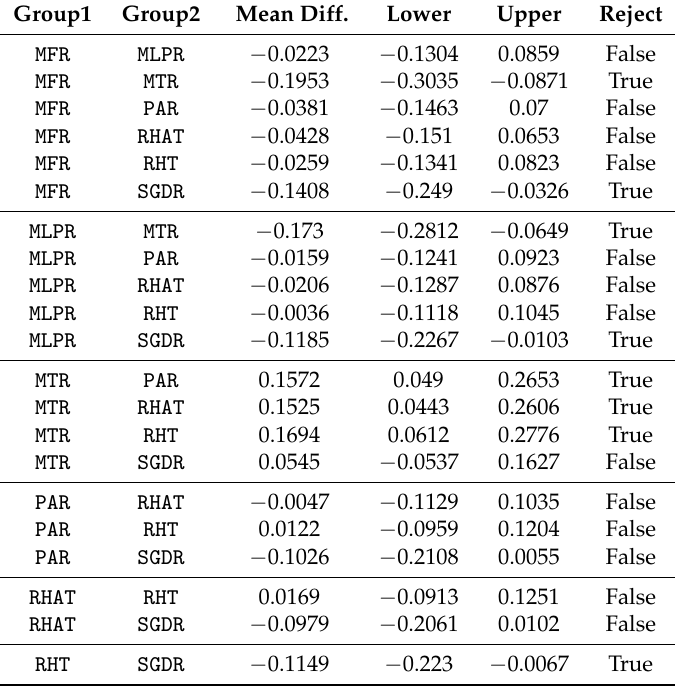
Table 13. Results of the Tukey’s range test for experiment